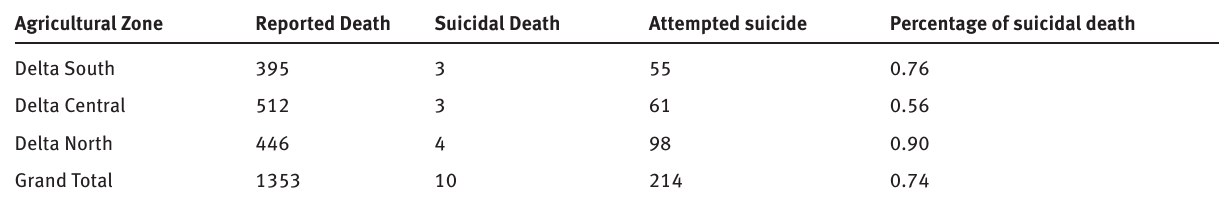
Agricultural Zone